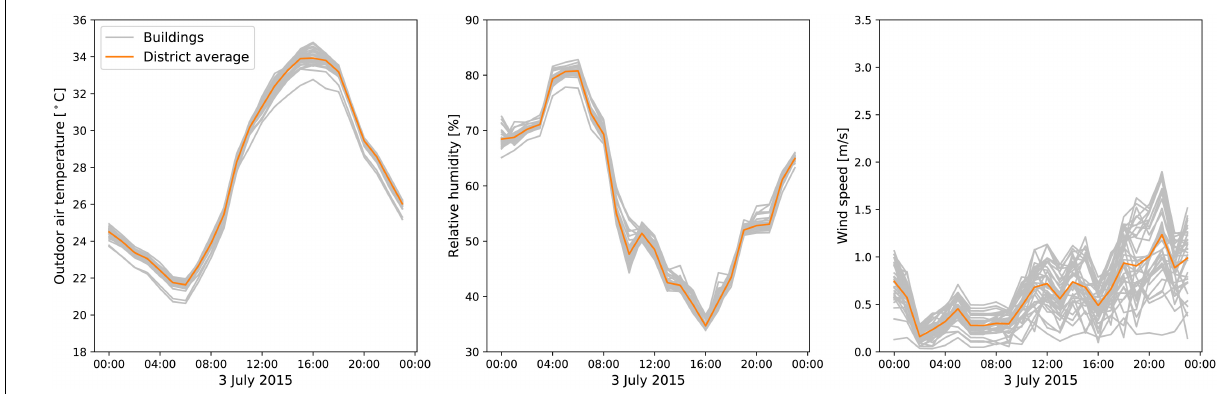
FIGURE 9 | Simulated mean air temperature, relative humidity and wind speed around